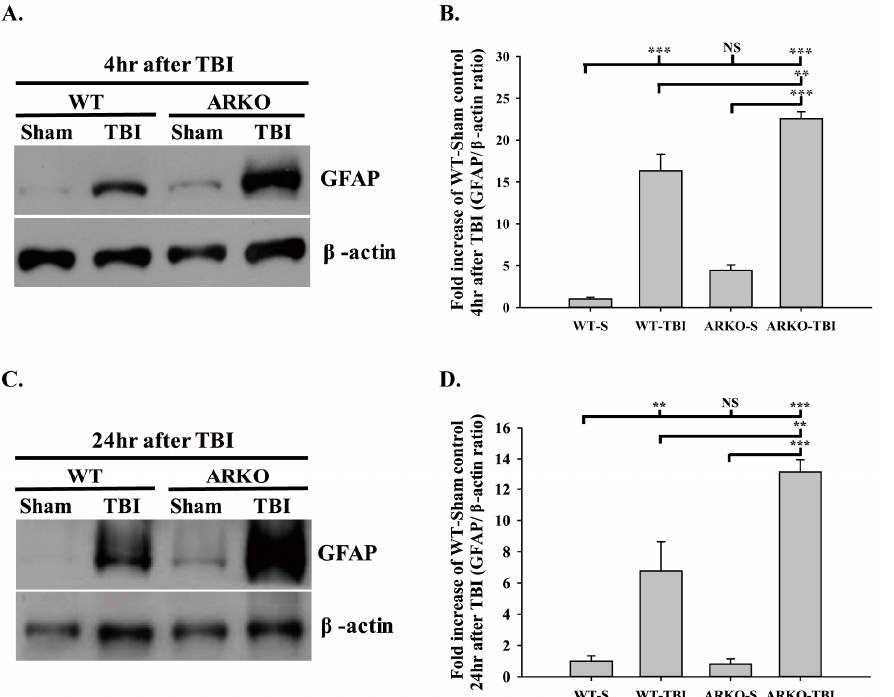
Figure 2. Androgen receptor knockout promoting GFAP expression induced by TBI GFAP expression was evaluated by Western blot. ( A ) Androgen receptor knockout induces GFAP expression at 4 h after TBI. ( B ) The quantitative data of GFAP level at 4 h following brain injury. ( C ) ARKO mice show TBI-induced GFAP expression enhancement compared with WT 24 h after TBI. ( D ) Quantitative data of GFAP level at 24 h following TBI. All data are presented as the mean ± standard error. NS, no significant difference; ** p < 0.01, and *** p < 0.001; n = 3 in each group.